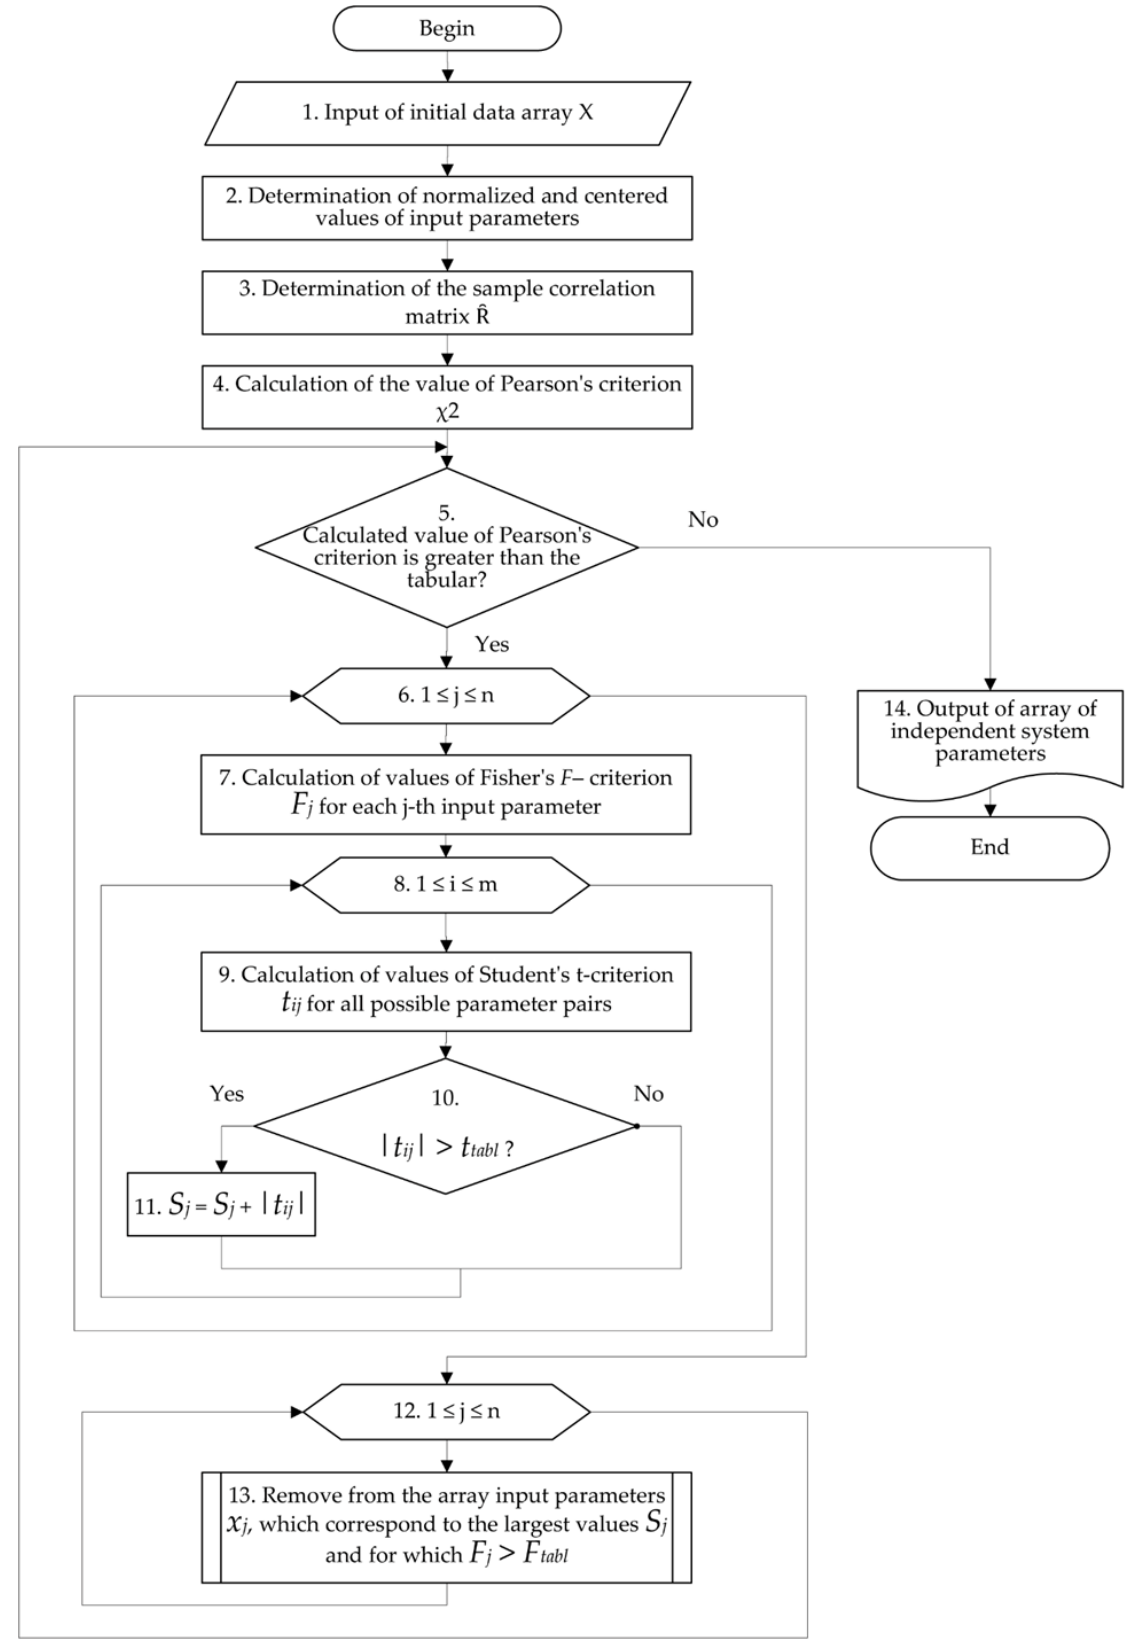
Figure 1. Algorithm for eliminating multicollinearity of input parameters of the TrEECS model based on the Farrar-Glober method.